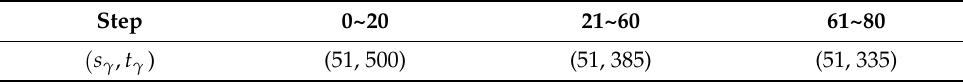
Table 4. The parameters for different detection probability.